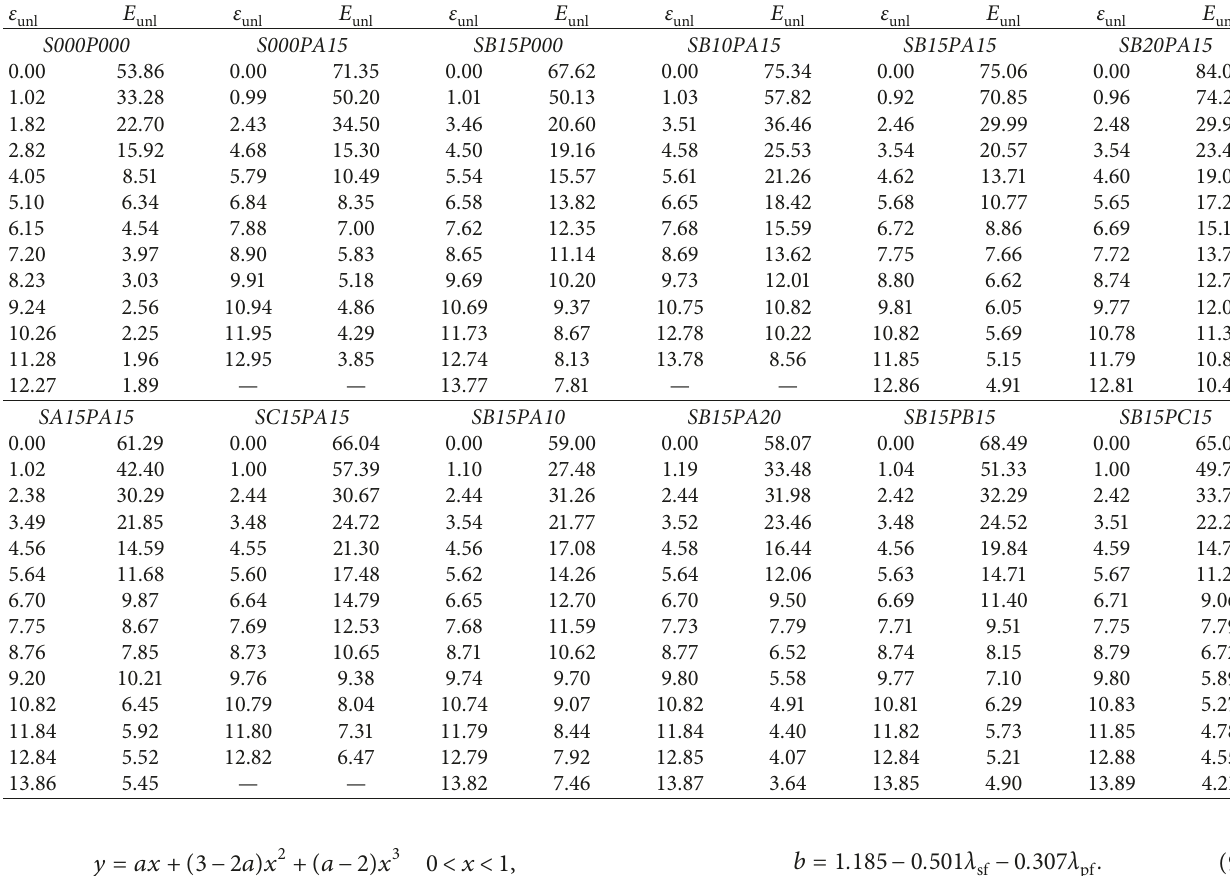
Table 5: Elastic stiffness versus unloading strain for concrete